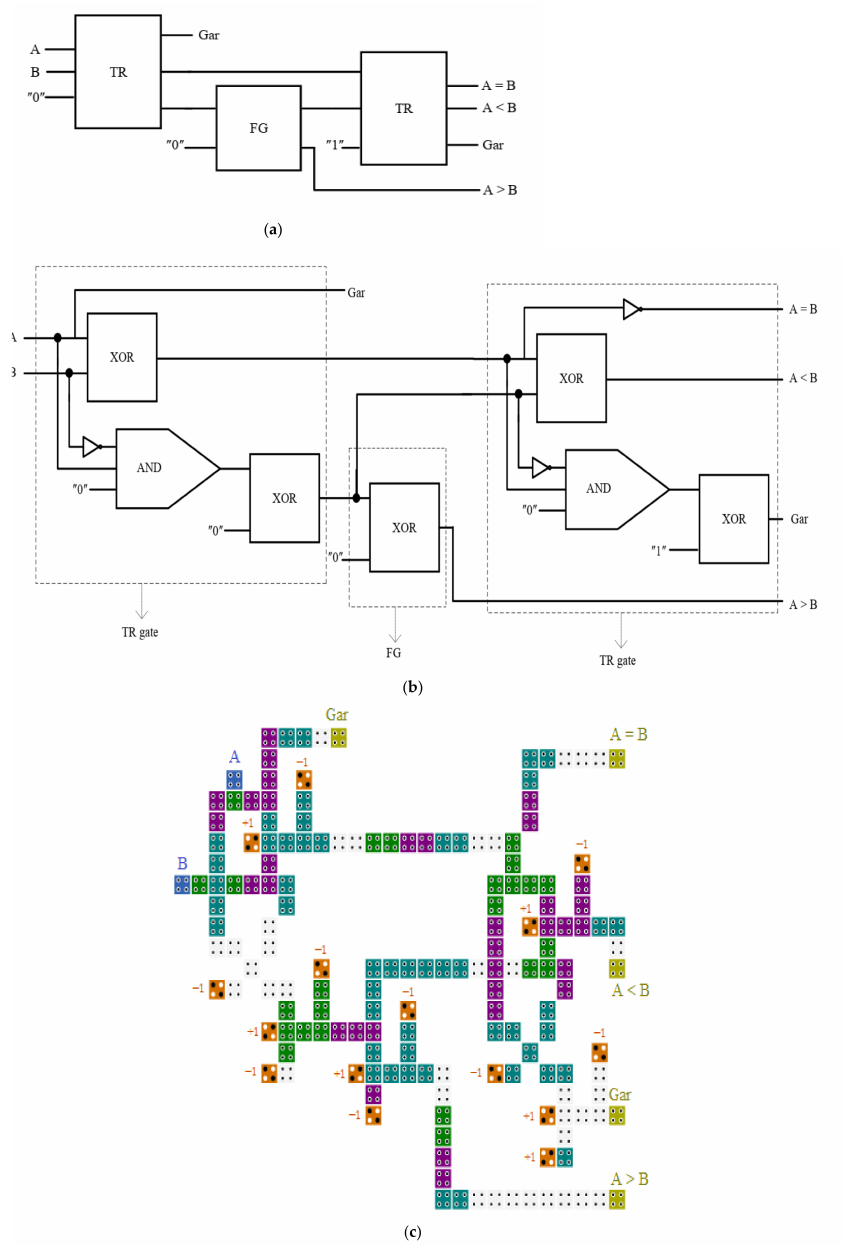
Figure 11. The 1-bit comparator ( a ) logic diagram, ( b ) block diagram, and ( c ) QCA